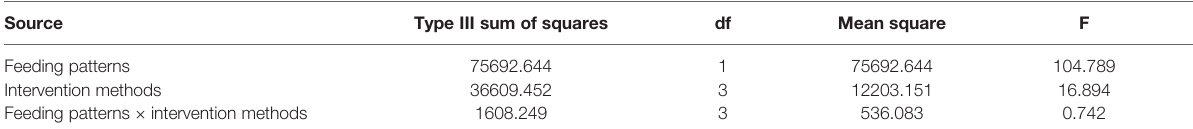
TABLE 3 | Multi-factor analysis of variance of locomotor